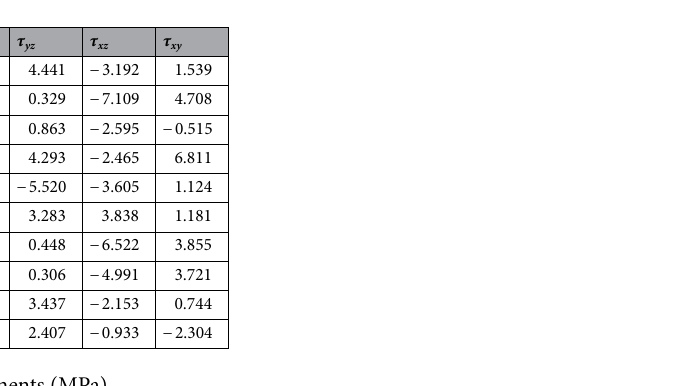
Table 2. In situ stress components